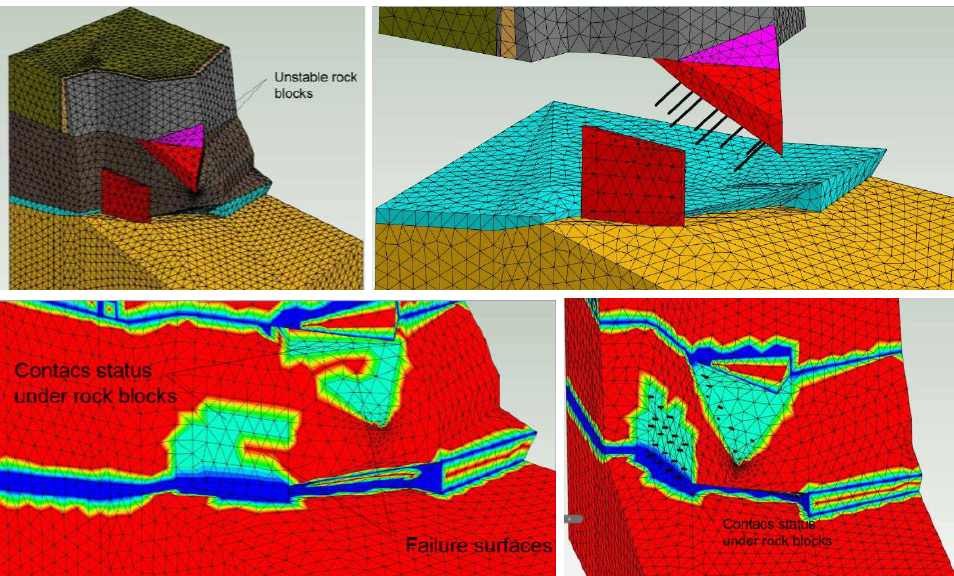
Figure 26. Design of geological intervention at the rock blocks at the southern end of the castle, similar to the ones carried out at the location below the tower: ( top ) location of unstable rocks, where different colours indicate different material properties, such as masonry, soil and rocks ( left ), and proposed anchors ( right ); ( bottom ) comparison of contact status under the rock blocks before and after the introduction of anchors at the southern end of the castle. Red areas within the annotated contact surfaces indicate the presence of failure areas.